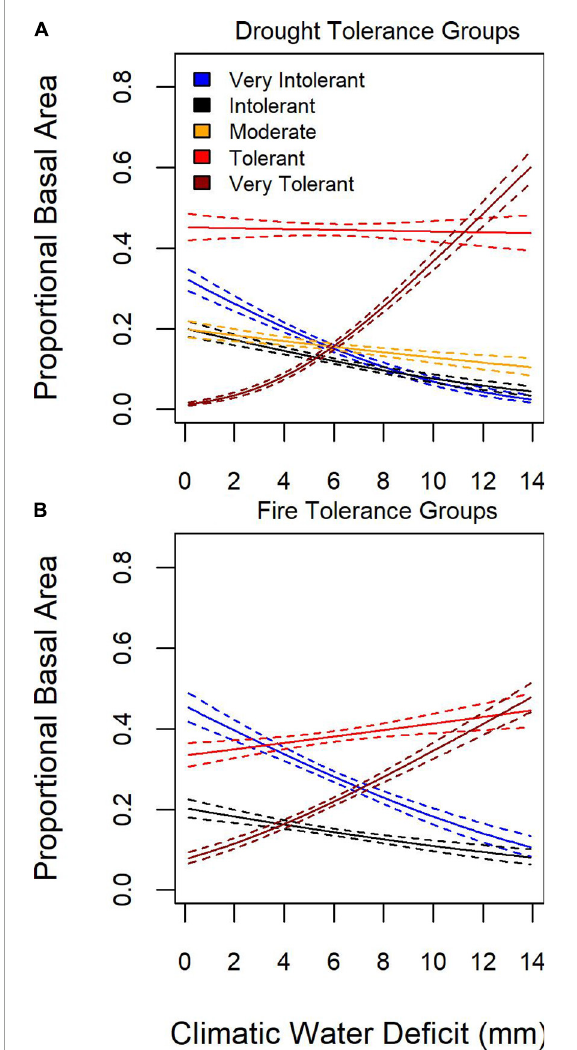
FIGURE6 Mean (solid line) and 95% confidence interval (dashed line) for proportional basal as a function of water deficit for (A) five drought tolerance groups and (B) four fire tolerance